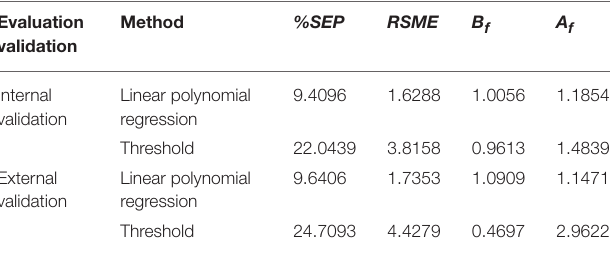
TABLE 6 | Mathematical internal and external evaluation based on TTD of SEA by two methods for establishing the